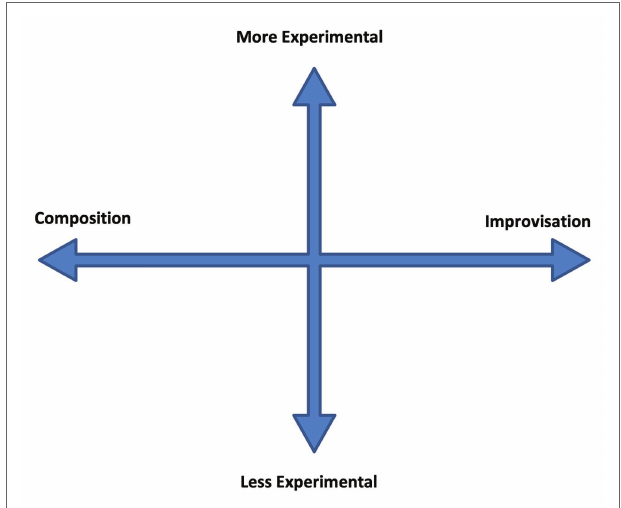
FIGURE 1 | The Experimental Composition Improvisation Continua